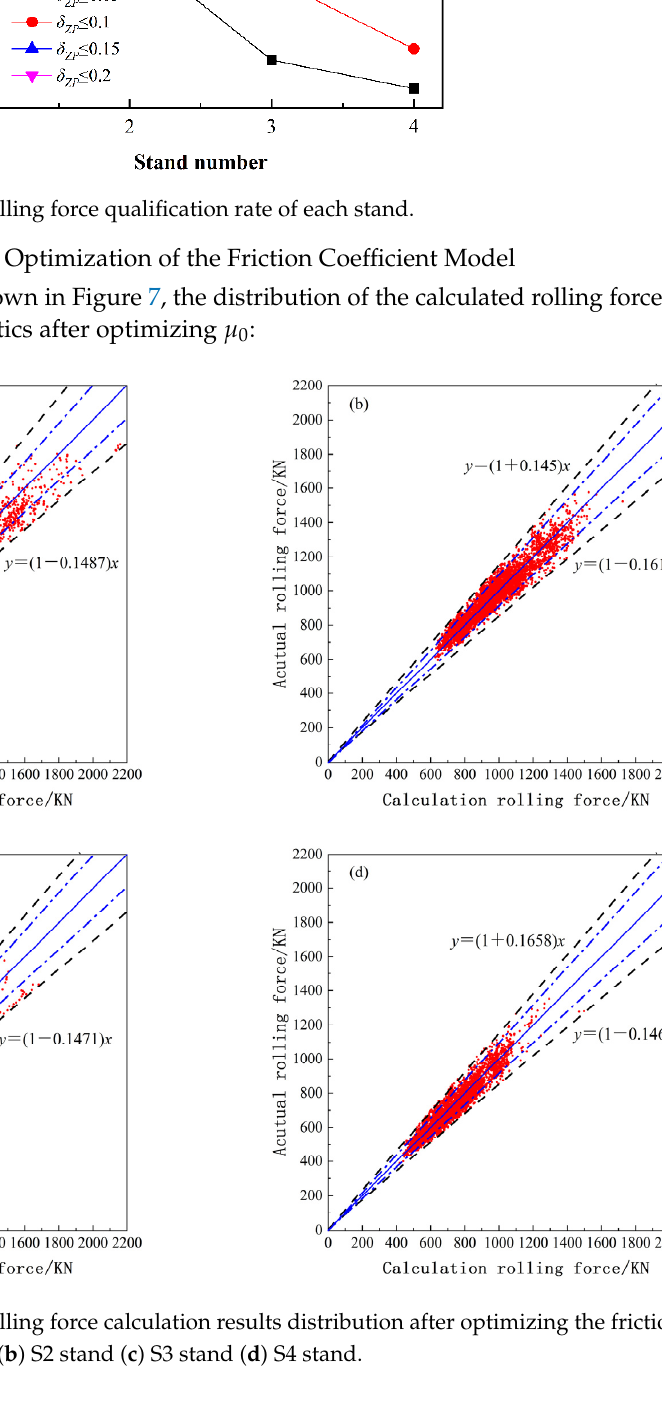
Figure 5. Rolling force calculation results distribution before optimization: ( a ) S1 stand, ( b ) S2 stand, ( c ) S3 stand, ( d ) S4 stand.